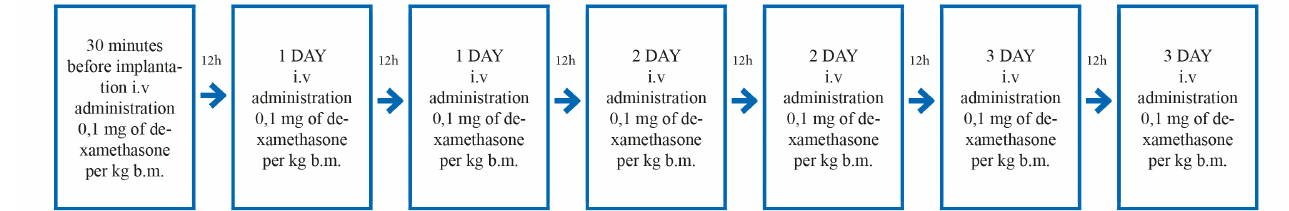
FIGURE 2 - Scheme of administration of corticosteroids in the first